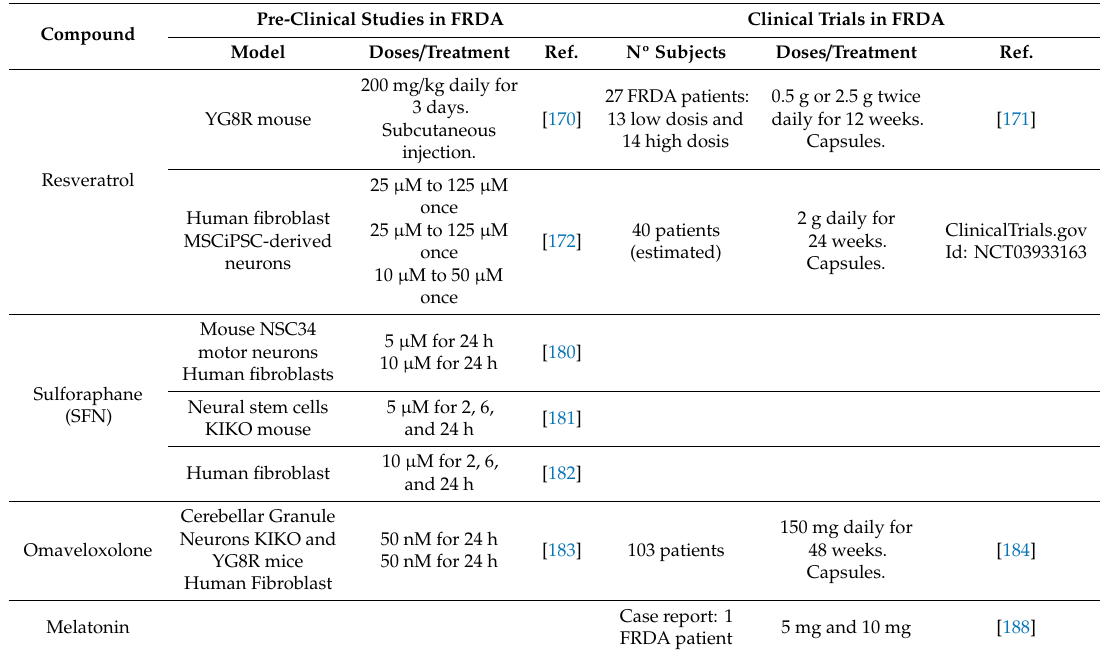
Table 1. Pre-clinical and clinical antioxidant therapies in